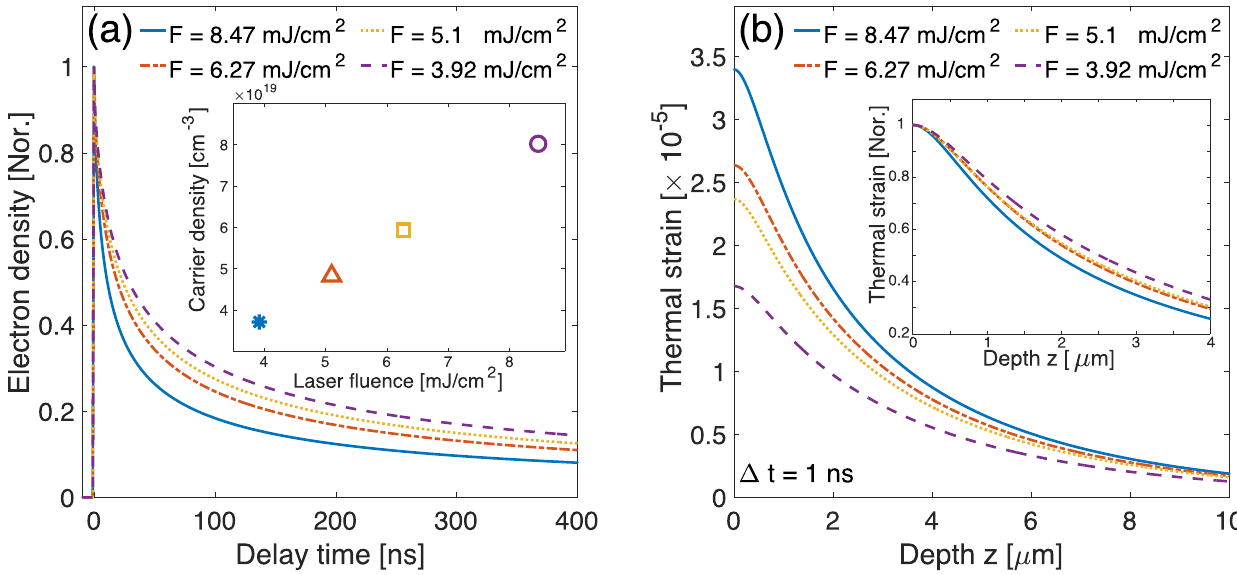
Figure 4. ( a ) Normalized electron density from the surface within 3 µ m as a function of delay times, and the estimated carrier densities in the corresponding region as a function of laser fluence (inset). ( b ) Calculated distribution of thermal strains at ∆ t = 1 ns with laser fluence. Inset indicates that the higher laser fluence results in the smaller thermal distribution